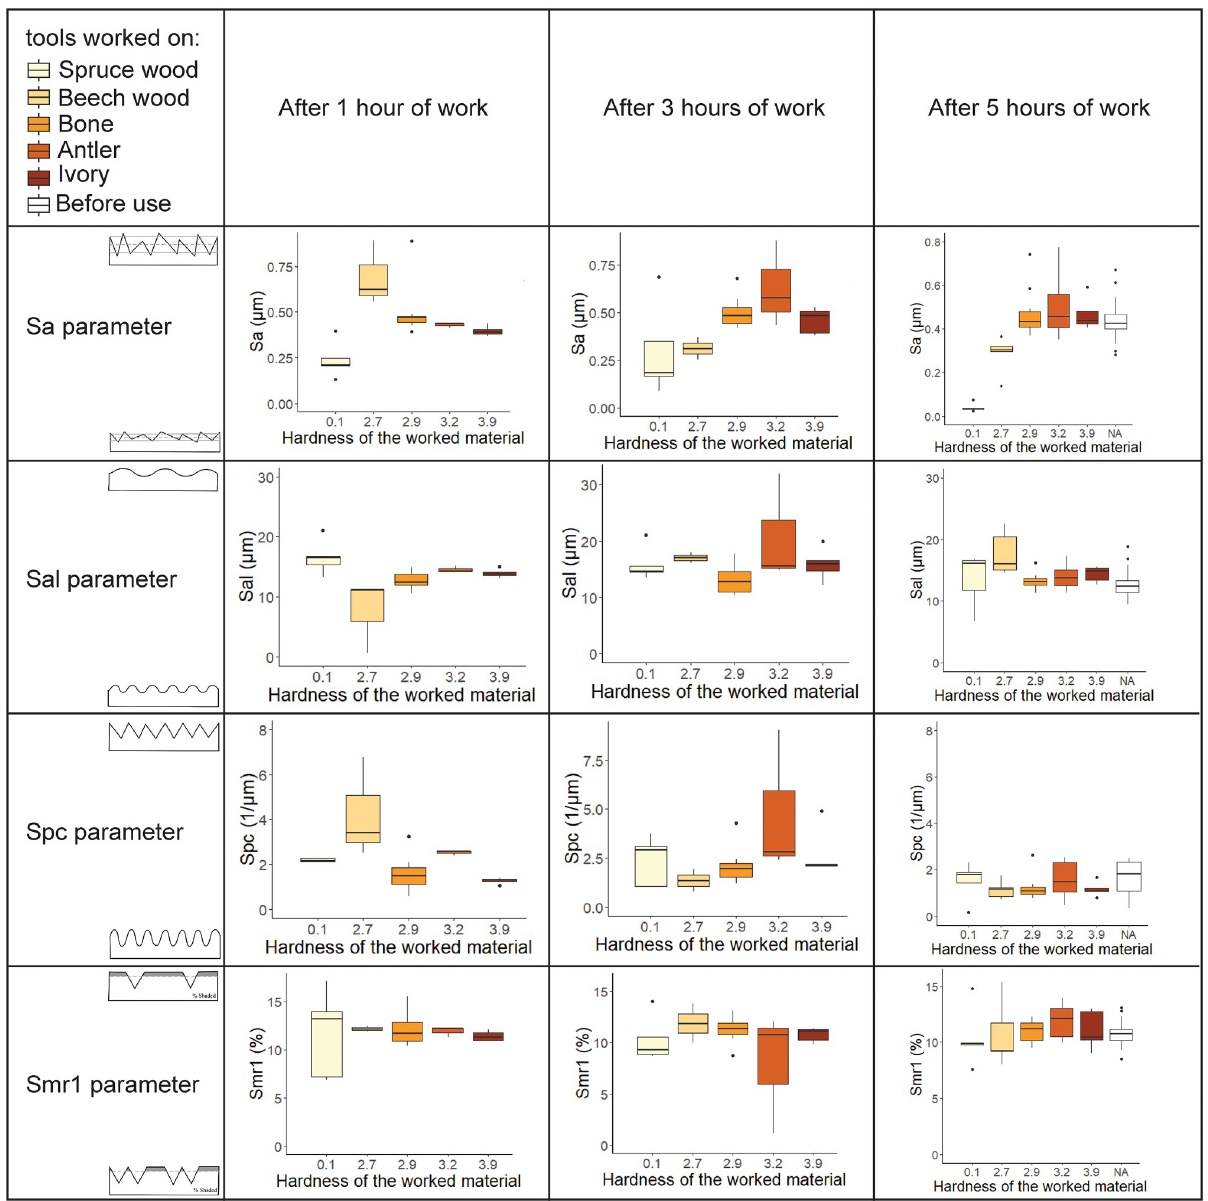
Fig 8. Boxplots showing the evolution of flint roughness parameters Sa, Sal, Spc, and Smr1 after 1 hour, 3 hours and 5 hours of use on worked materials of various hardnesses. The diagrams in the first column represent the expected microtopography for a high value (on the top part of the cell) or low value (on the bottom part of the cell) for each parameter (extract from Martisius et al., 2018